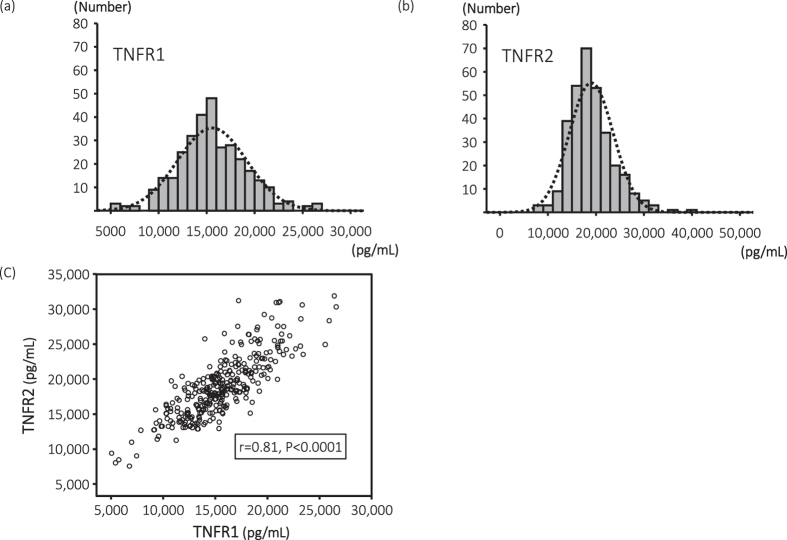
Histograms and scatter plots of TNFR1 and TNFR2.The median (25th, 75th percentiles) TNFR1 (Fig. 1a) and TNFR2 (Fig. 1b) levels were 15,383 (13,349, 17,888) and 18,504 (15,790, 21,335) pg/mL, respectively. Strong positive correlations between TNFR1 and TNFR2 were observed (Fig. 1c).